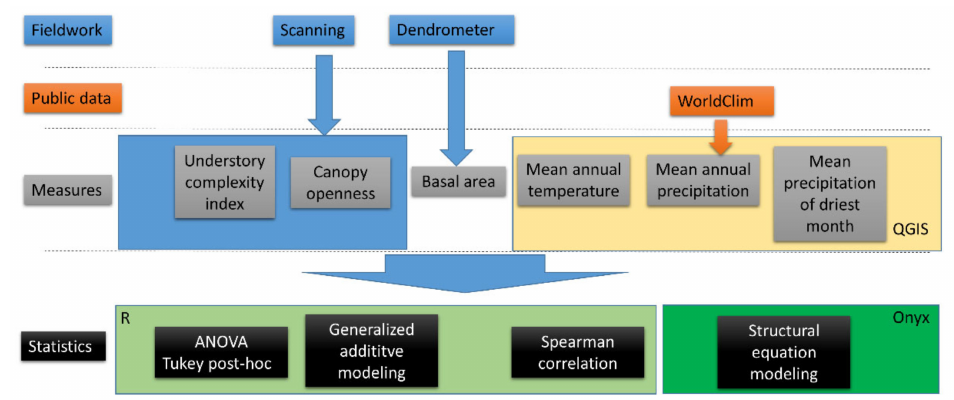
Figure 5. Methods flowchart of this study.